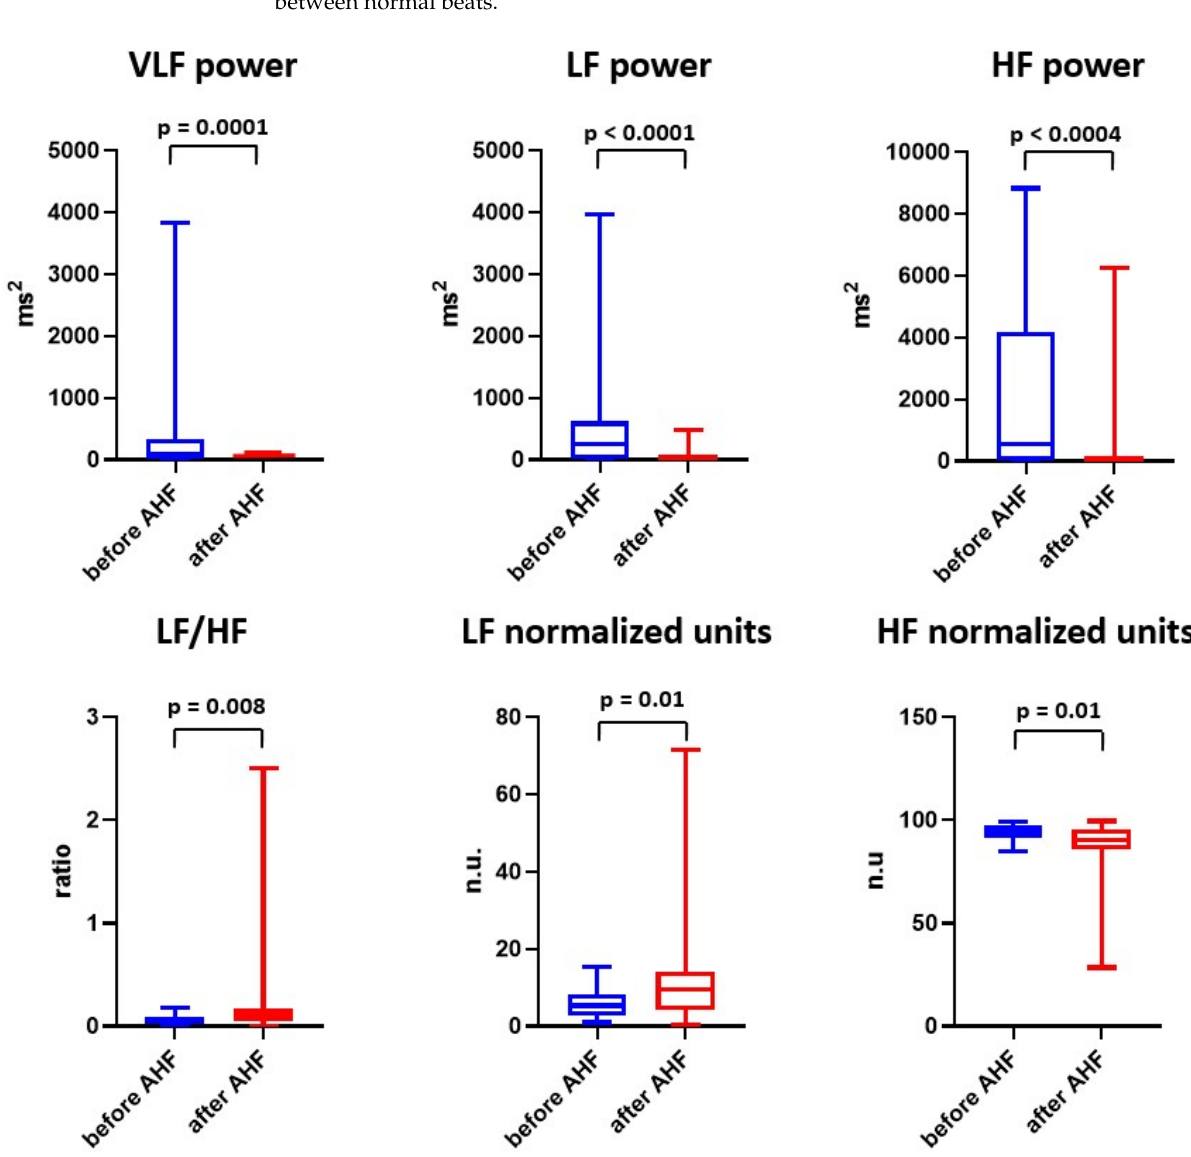
Figure 3. Effect of acute heart failure on frequency-domain parameters of heart rate variability. Data are expressed as median with interquartile range, minimum and maximum value. AHF = acute heart failure; HF = high frequency; LF = low frequency; n.u. = normalized units; VLF = very low frequency.